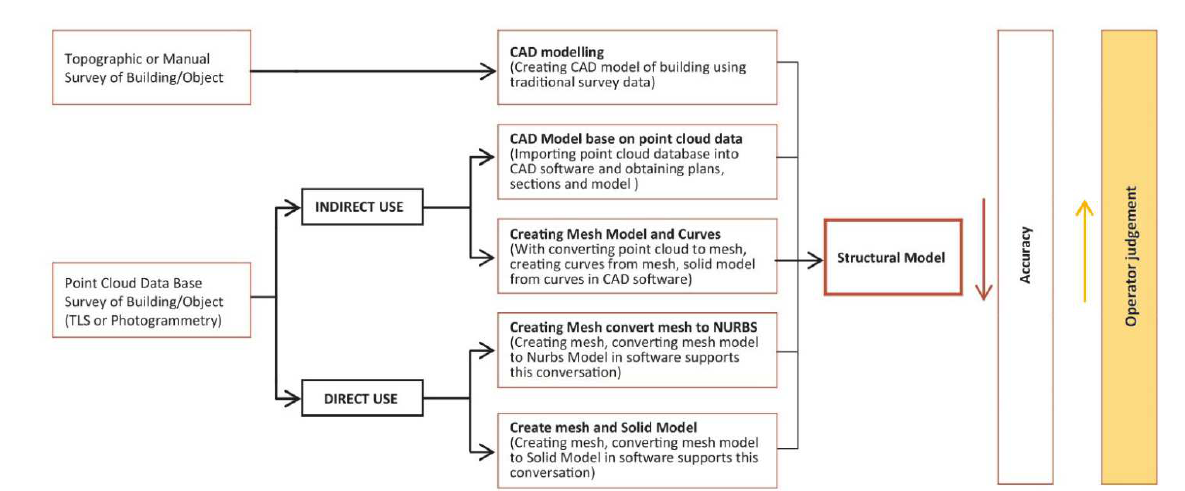
Figure 1 - Classification of methods for the generation of structural